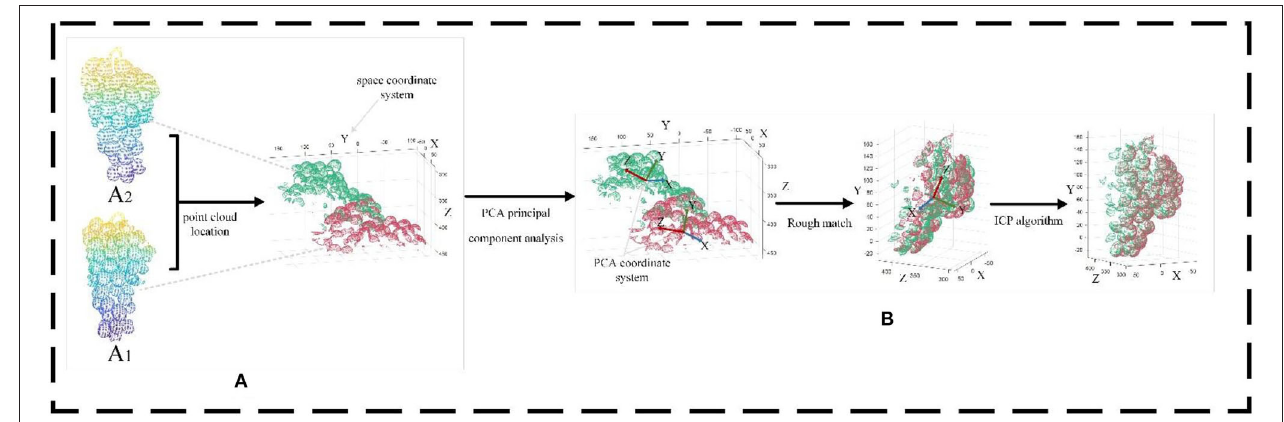
FIGURE 6 | Matching results of the ICP algorithm and the ICP algorithm after applying the PCA algorithm are compared. (A) Red denotes the A 1 point cloud, and green denotes the A 2 point cloud. (B) Registration result of the improved ICP algorithm.